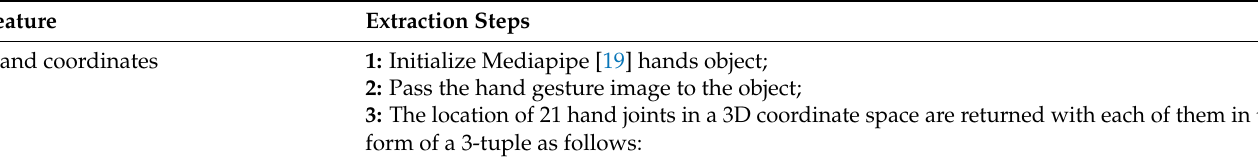
Table 5. Features